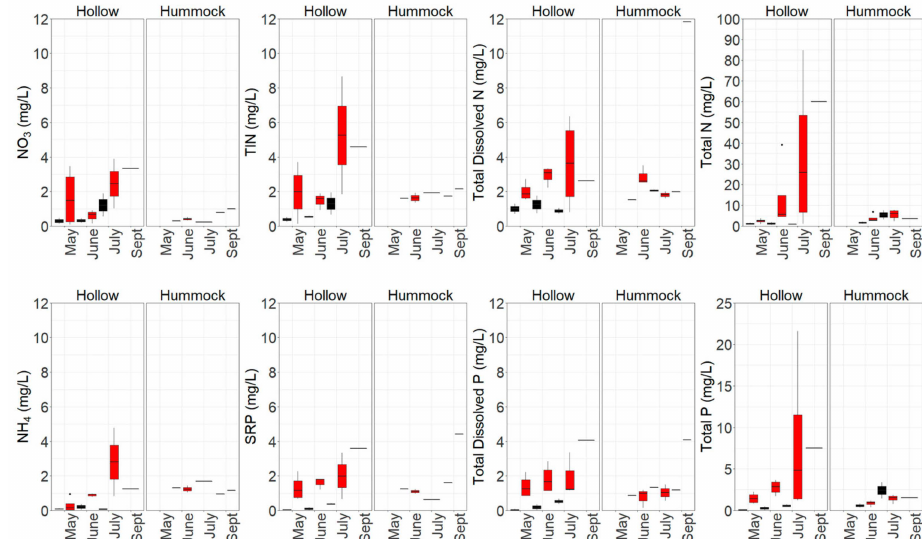
Figure 2. Shallow leachate concentrations over the growing season, comparing the Unburned (red) and Burned (black) areas and the microtopographical di ff erences observed.